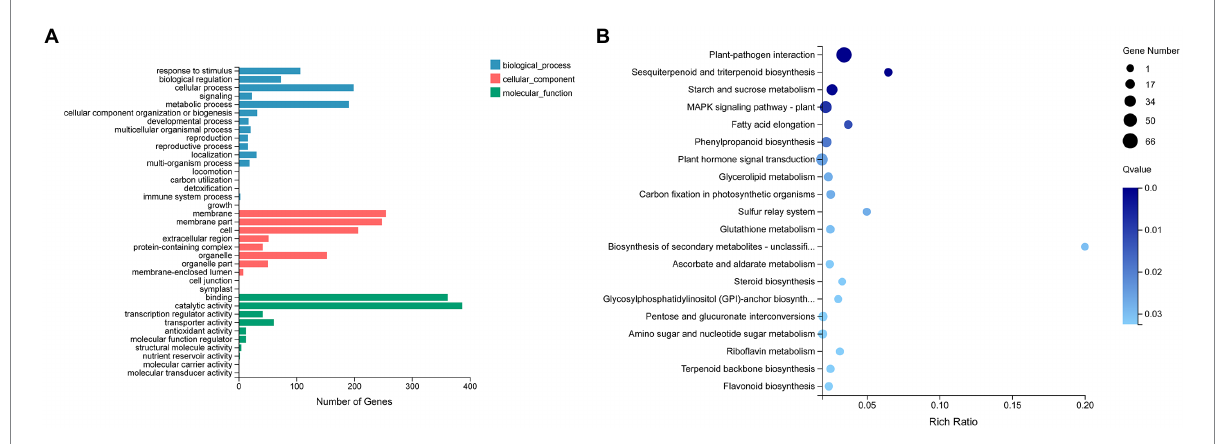
FIGURE 3 Gene expression analysis of transgenic and WT N. benthamiana . (A) GO categorization of all differentially expressed genes. The differentially expressed genes were classified into three subontologies: Biological Process, Cellular Component, and Molecular Function. Further KEGG enrichment of the screened differentially expressed genes (B) . The size of the bubbles represents the number of genes annotated in a KEGG pathway, and the color represents the enrichment Q -value; the darker the color is, the smaller the Q